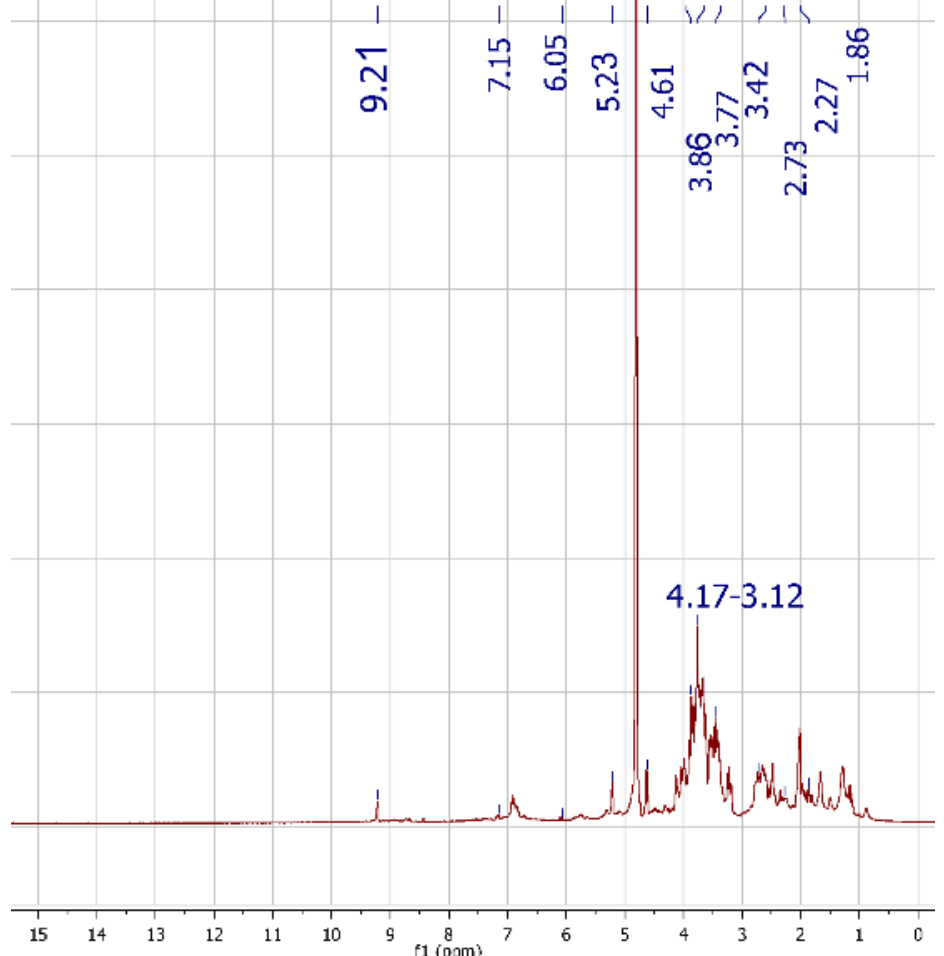
Figure 1. 1 H-NMR of 16.7 mg of LOMW sample in 0.6 μ L of D 2 O.